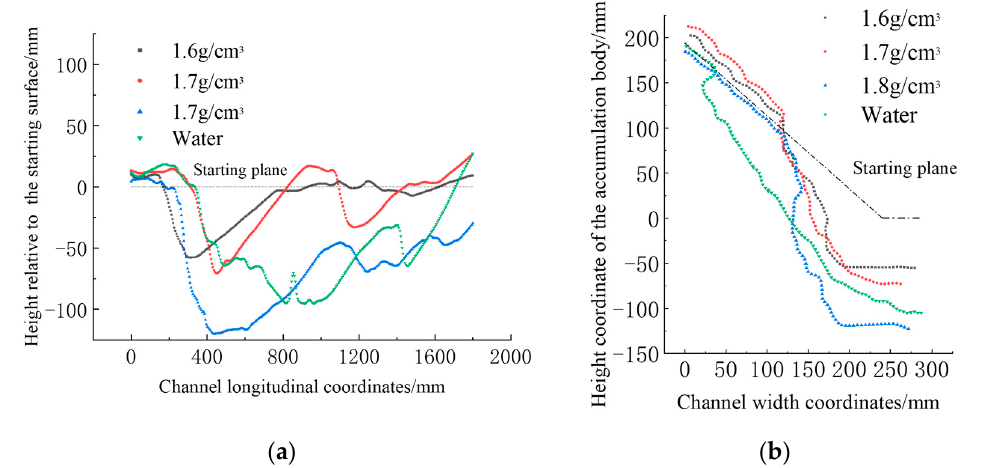
Figure 5. Characteristic cross-sections after debris flow erosion under different longitudinal slope conditions ( a ) Cross-section at maximum erosion depth. ( b ) Cross-section at maximum erosion width.